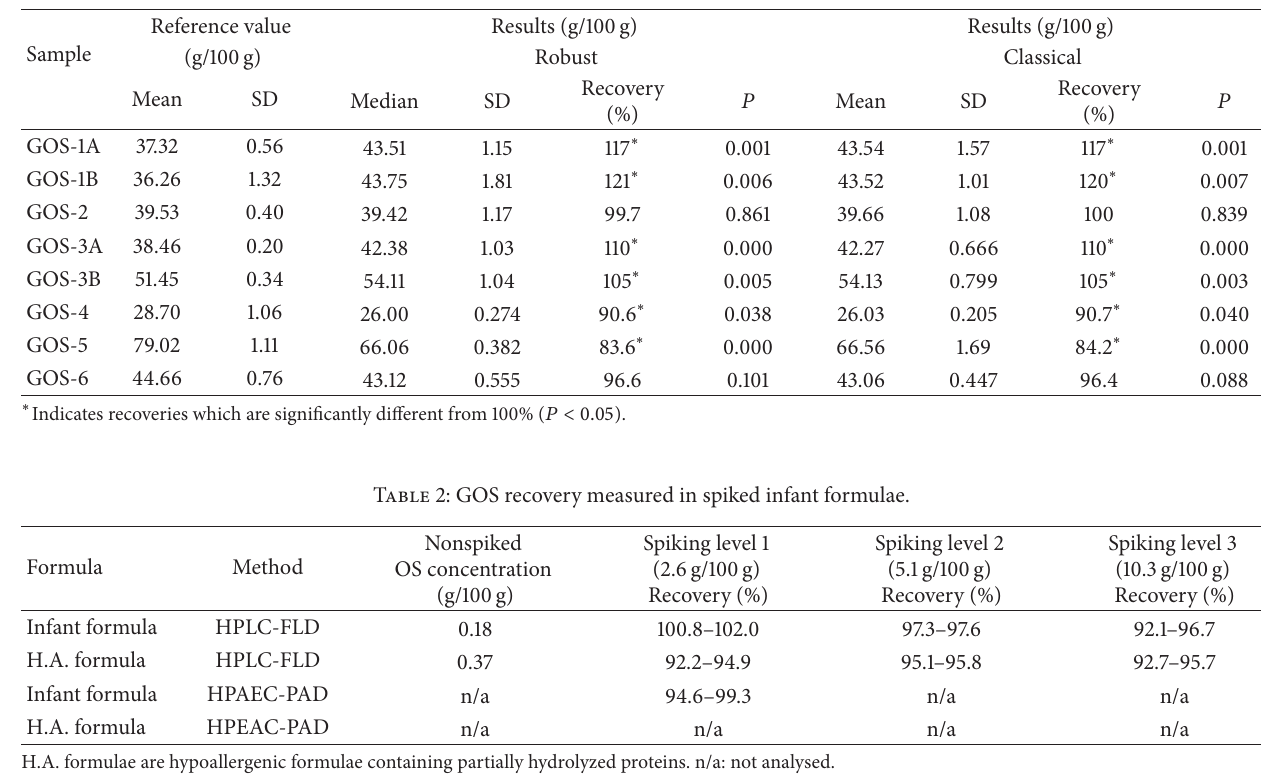
Table 1: Comparison of GOS content measured in different products using the AOAC method and the new method and comparison of results using both classical and robust statistics.